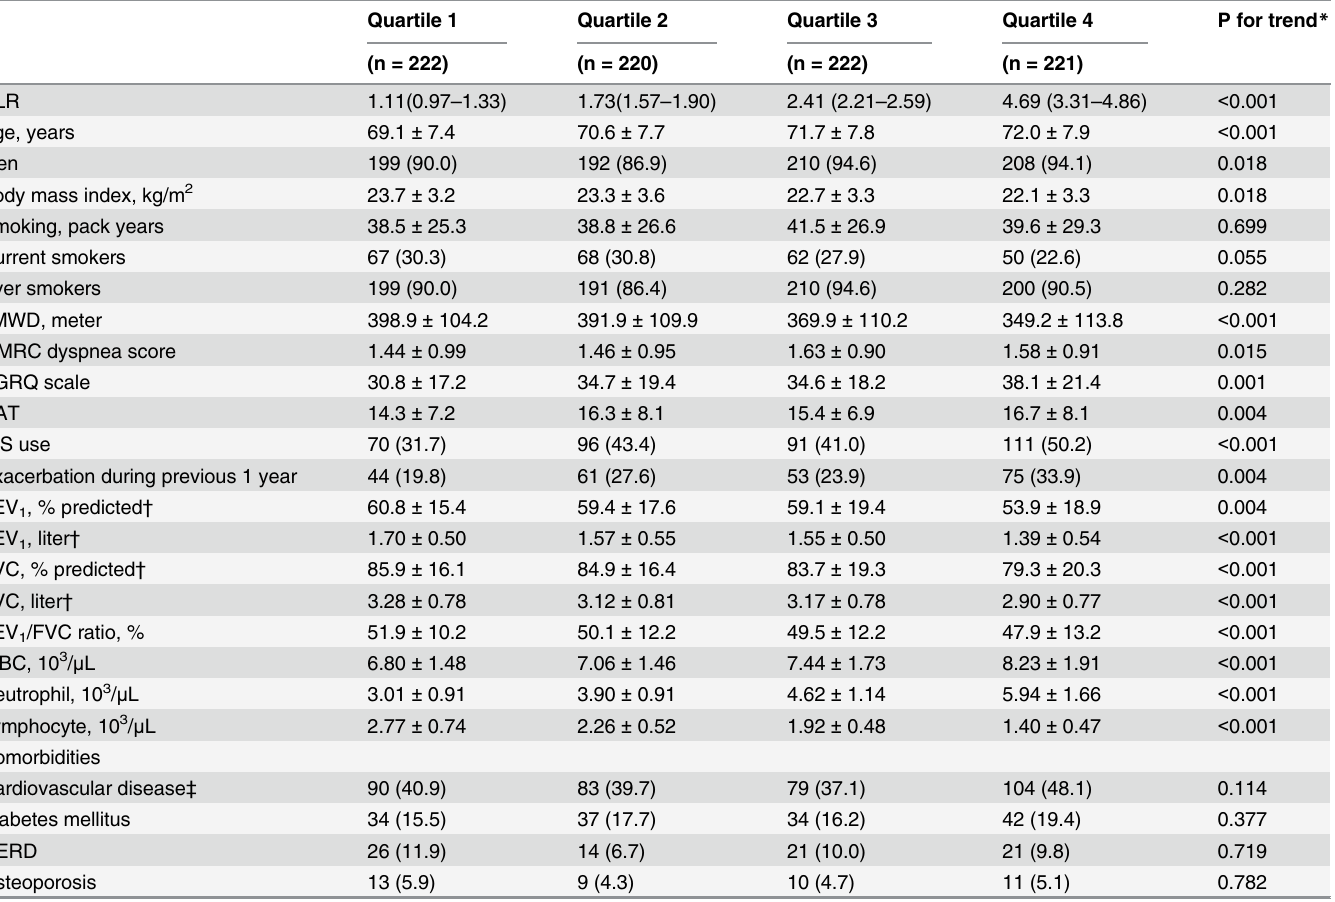
Table 1. Baseline Characteristics of Patients According to Quartiles of Baseline NLR